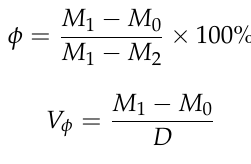
Figure 16. Correlation distribution of radial compression force and elastic index of